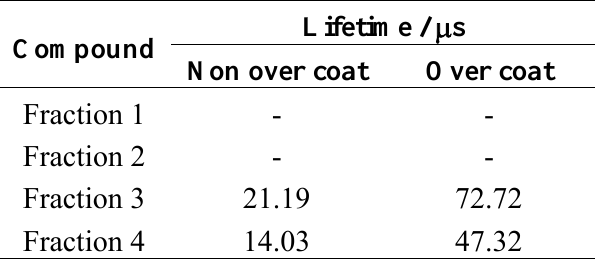
Table 12. Triplet lifetime of each fraction of 5c using Micher’s ketone as a quencher.